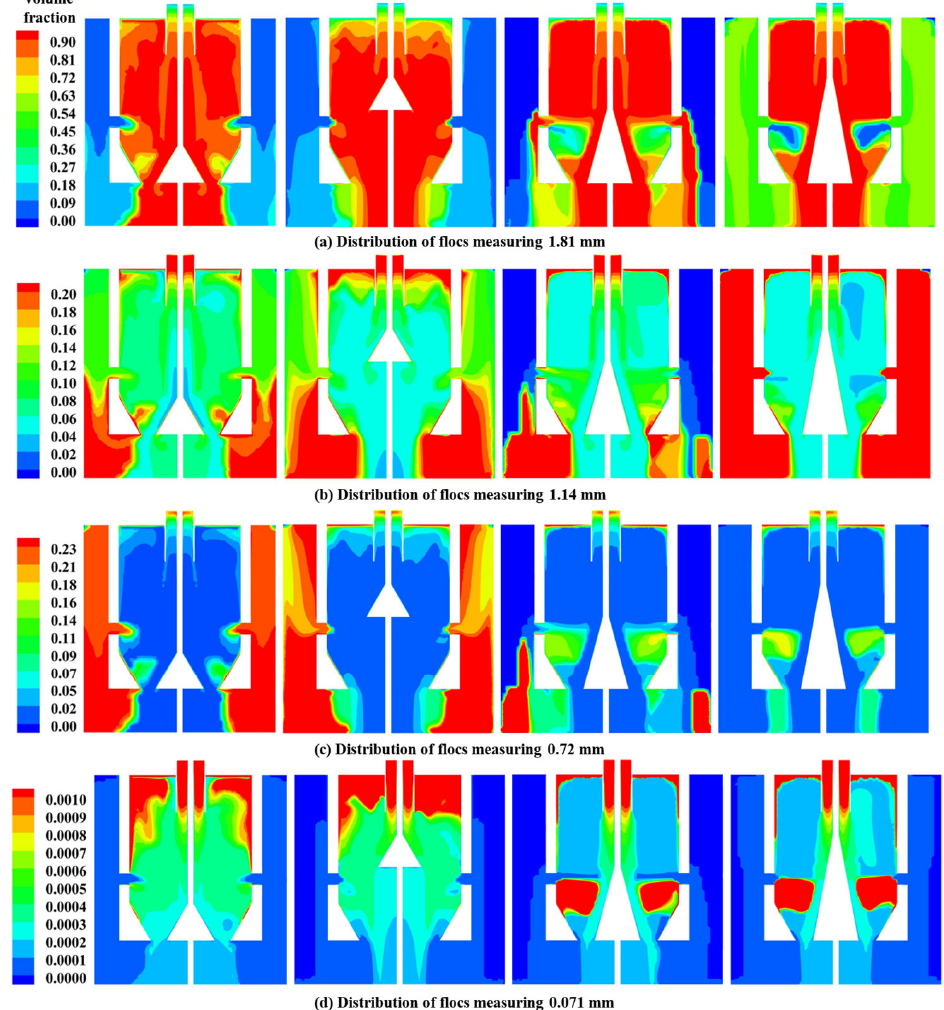
Figure 14. Floc distribution at each scale in the flow field of the feedwell: ( a – d ) show the distribution of four different sizes of flocs in the flow field inside and outside the feedwell, respectively.